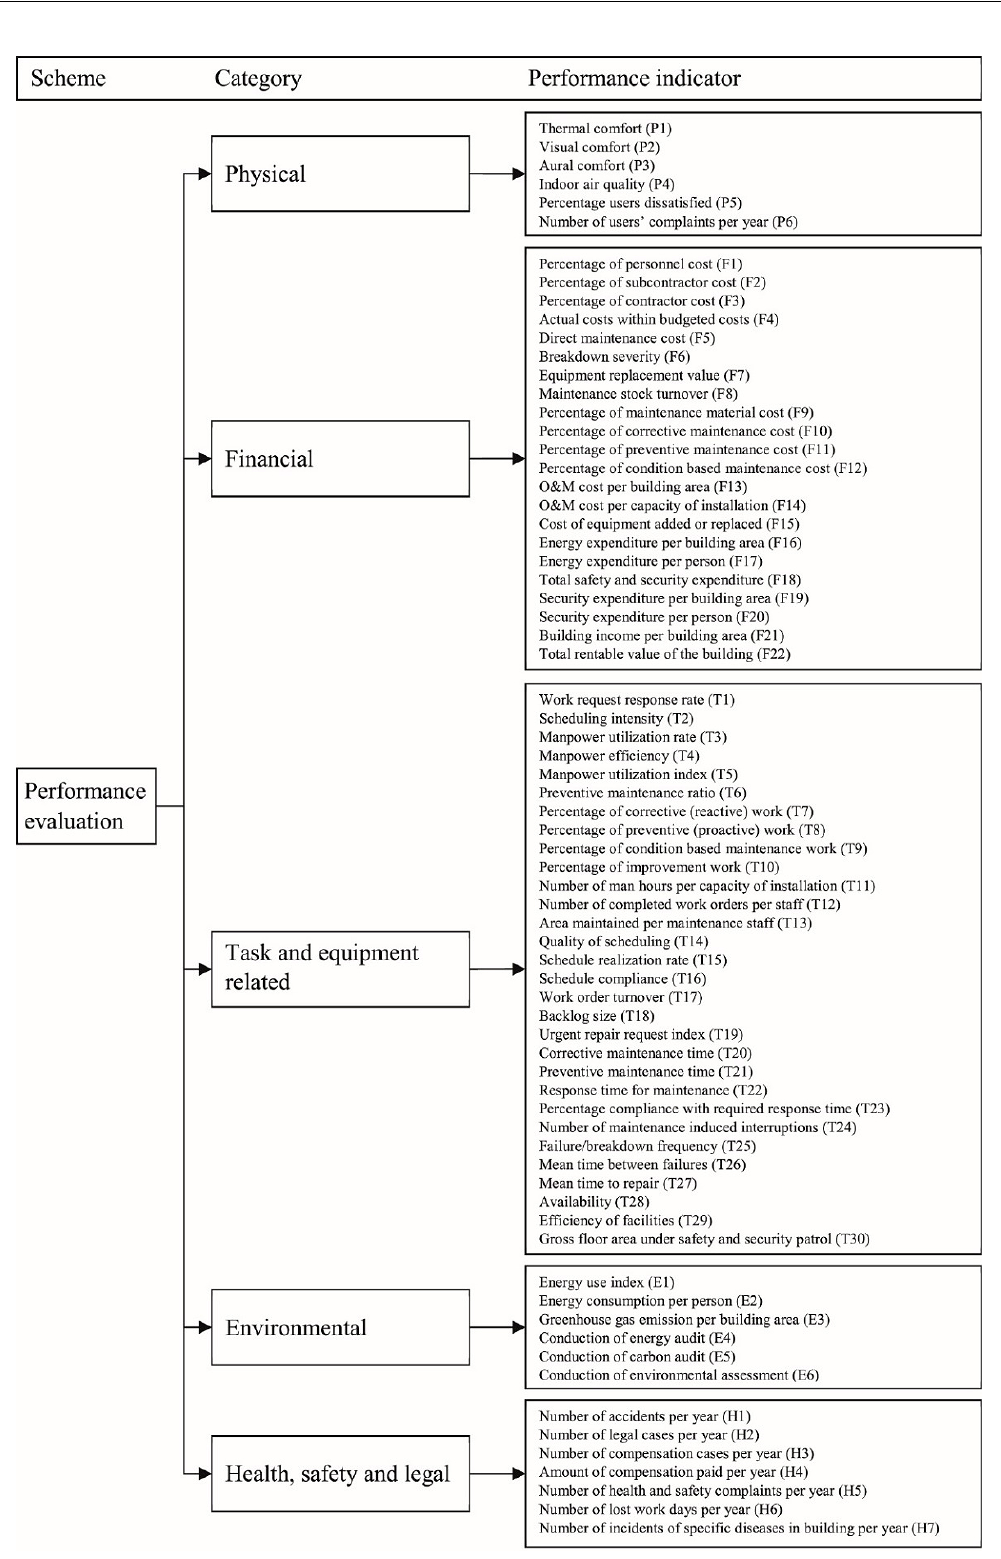
Fig. 5. A categorized summary of the performance